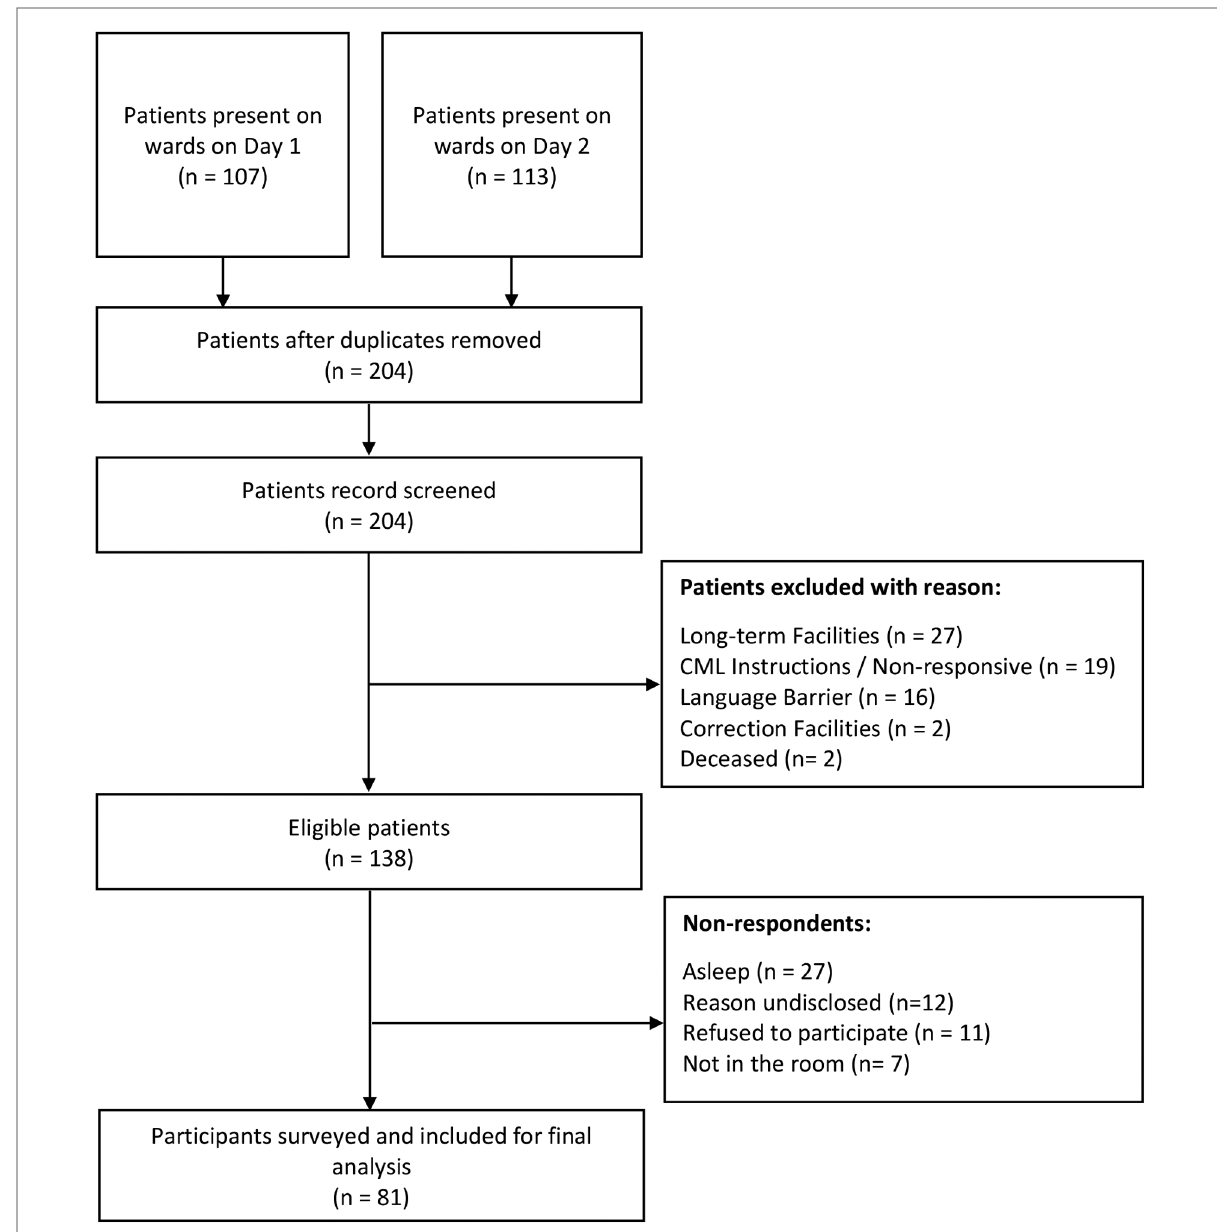
FIGURE 1 Recruitment of participants at Vancouver General Hospital internal medicine